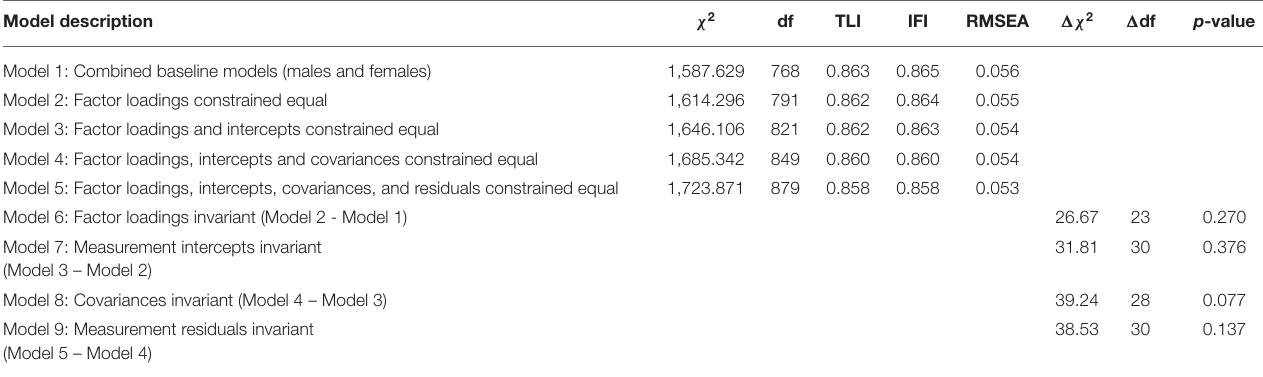
TABLE 5 | Invariance analysis across males and females in the measurement